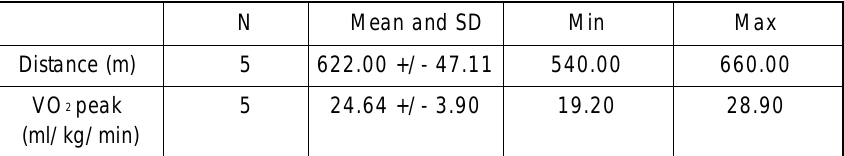
Table 2: Values for subset for distance and VO 2 peak.